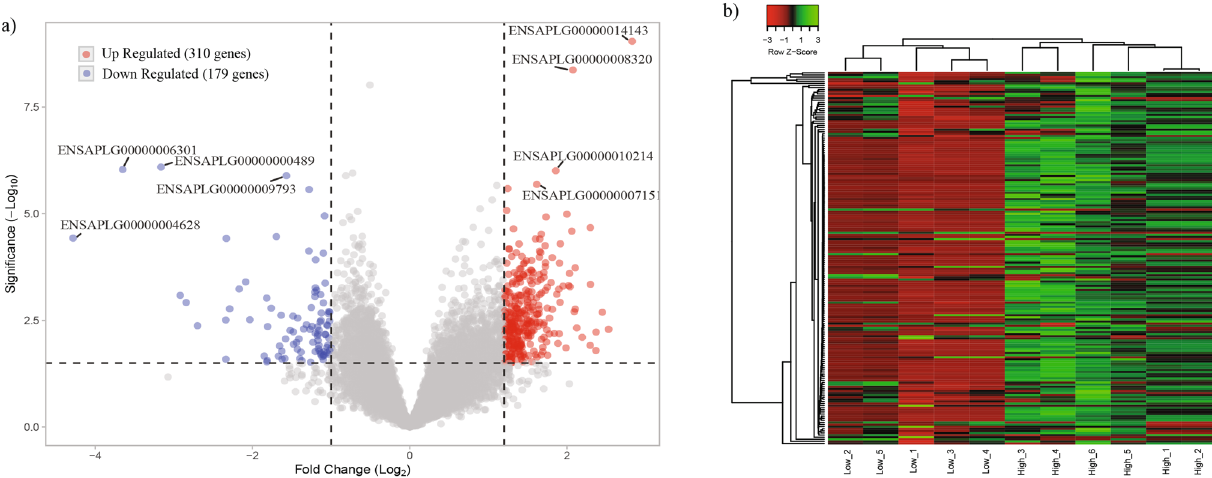
Figure 3. Differential gene expression between HEL and LEL ducks. ( a ) Volcano plot shows the DEGs between the HEL and LEL ducks. Each dot represents a gene. Red, and blue dots indicate upregulated, downregulated DEGs respectively, whereas grey dots indicate non differentially expressed genes. ( b ) Heat map showing the differential gene expression of HEL and LEL ducks. “Red” represents low relative expression level, and “green” represents high relative expression level. Each column and row represent a sample, and a gene